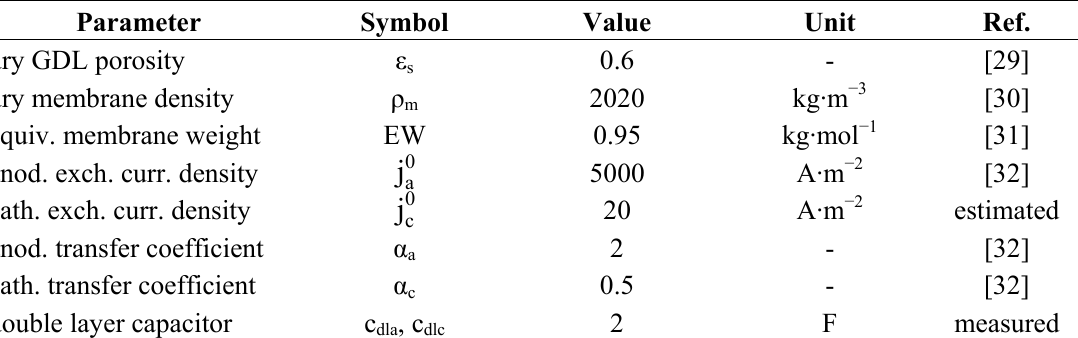
Table 4. Model physic parameters.